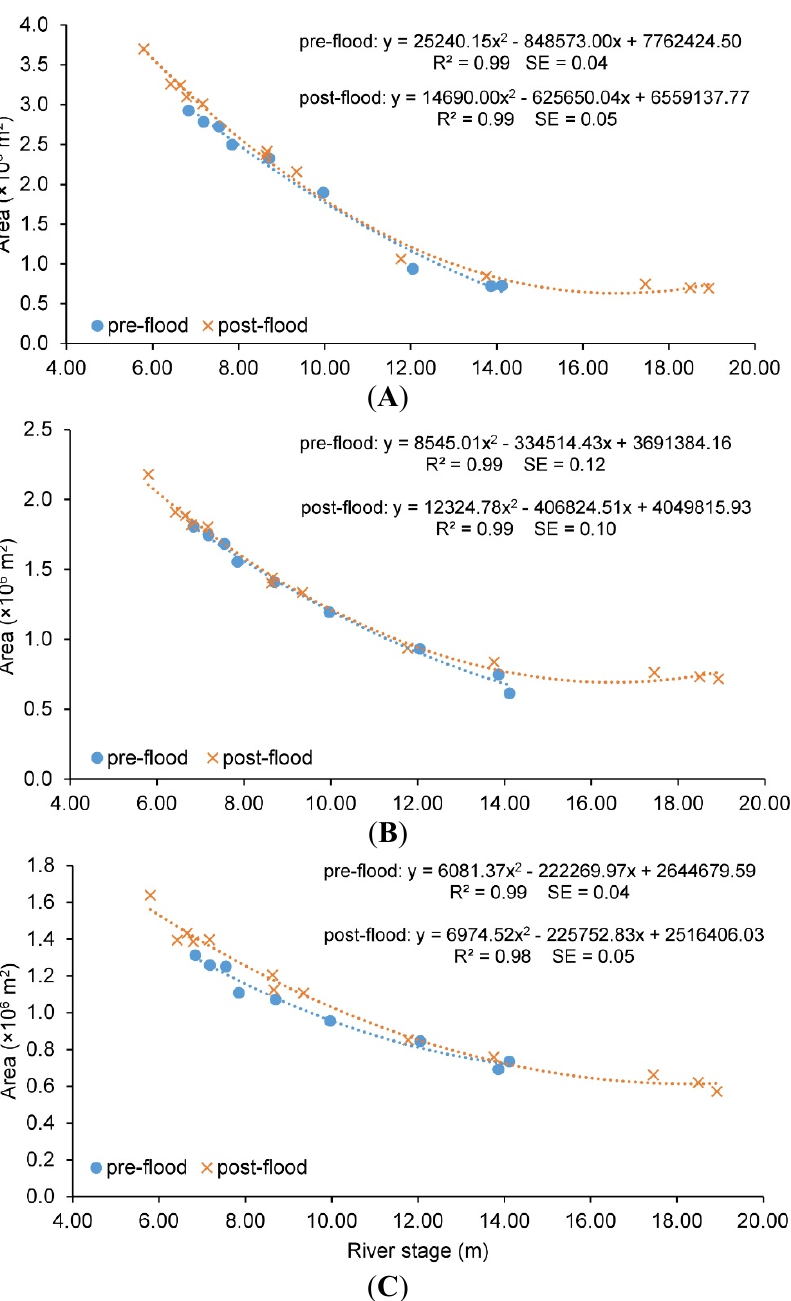
Figure 5. Rating curves of surface area-river stage for Shreves Bar ( A ); Angola Landing ( B ); and Miles Bar ( C ) near Tarbert Landing in the lowermost Mississippi River. SE (× 10 6 m 2 ) is the standard error of the